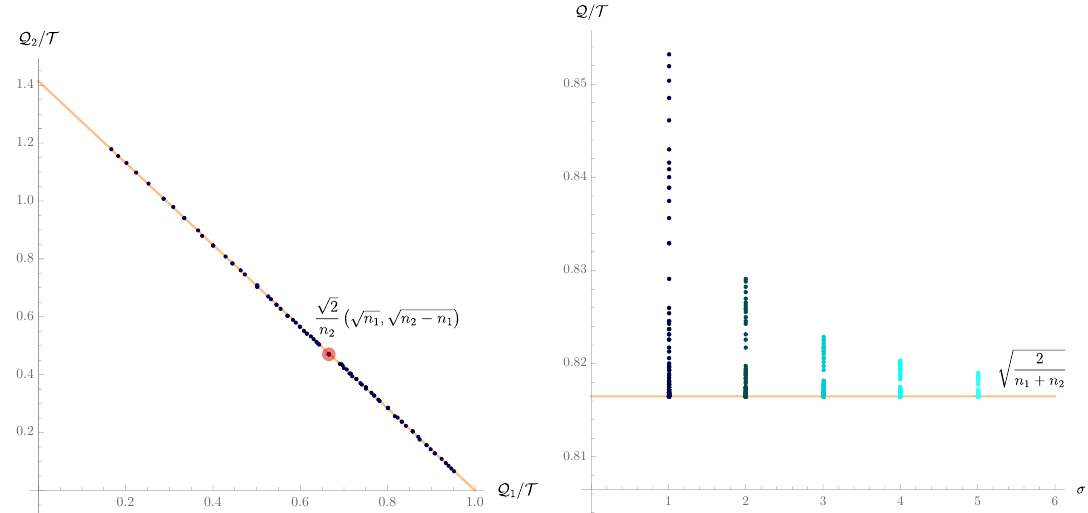
Figure 5 . The charge-to-tension ratios of BPS strings in a two modulus limit with n 1 = 2 and n 2 = 3 , i.e. K = − log( s 2 s 2 ) . To the left it is plotted the charge-to-tension vectors (5.13), which 1 draw a straight line independent of the cut-off Λ . To the right it is plotted the charge-to-tension ratio as we move along the flow, which is lower bounded by the extremality factor